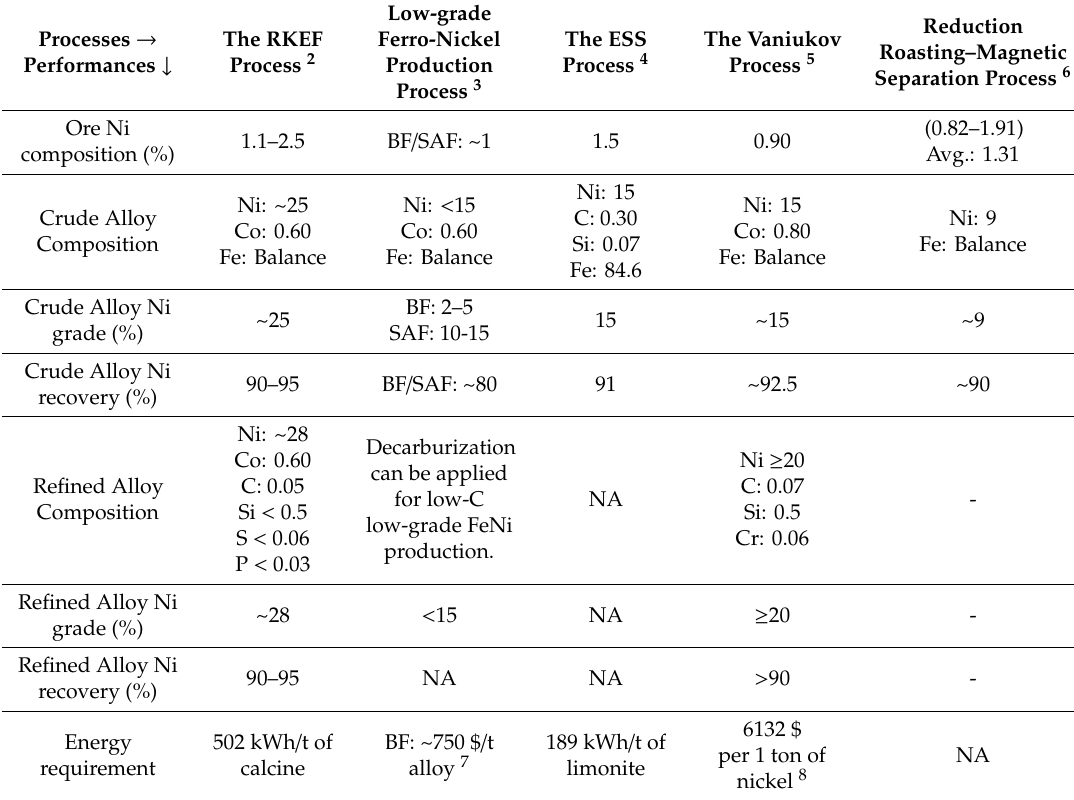
Table 1. Pyrometallurgical nickel extraction processes reviewed in this study 1